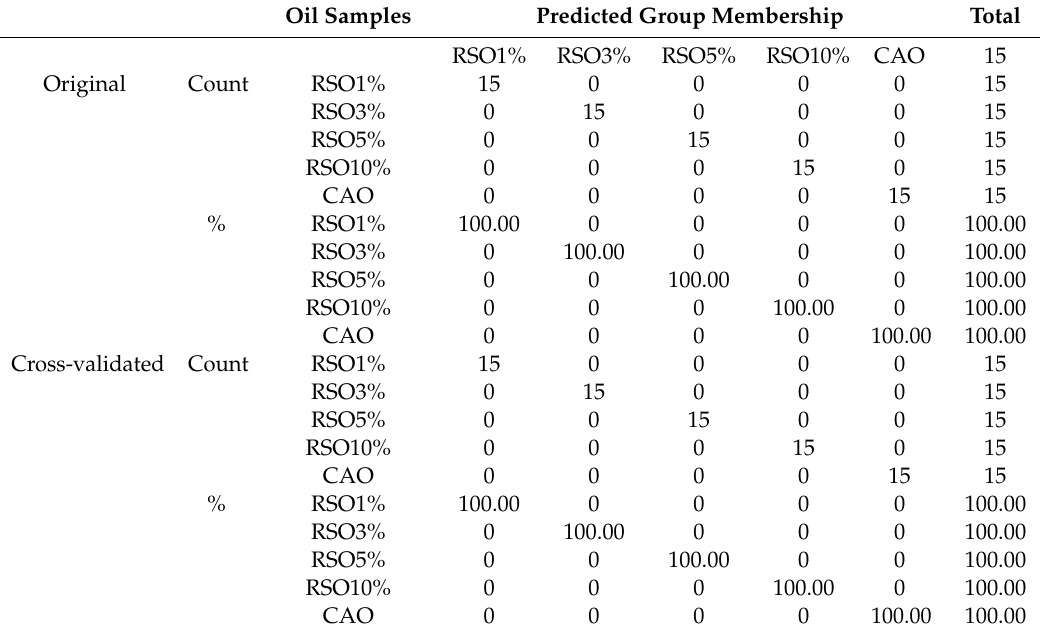
Table 3. Confusion matrix for the classification of CAO and CAO / RSO